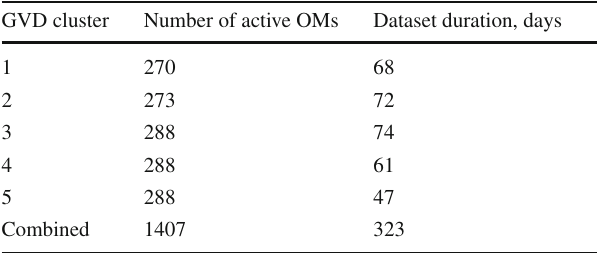
Table 1 Basic characteristics of the dataset used in this work (April 1–June 30,